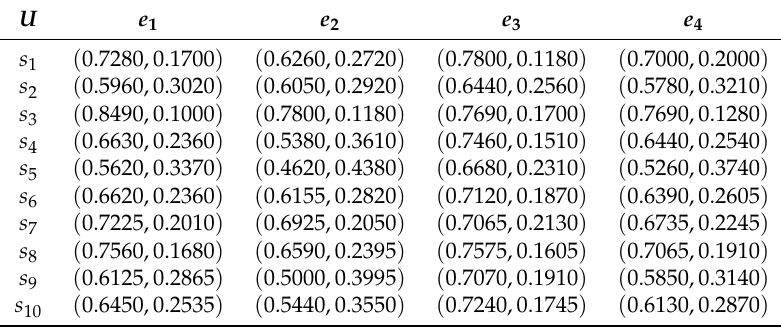
Table 4. Intuitionistic fuzzy soft set I = ( (cid:101) F , C ) .